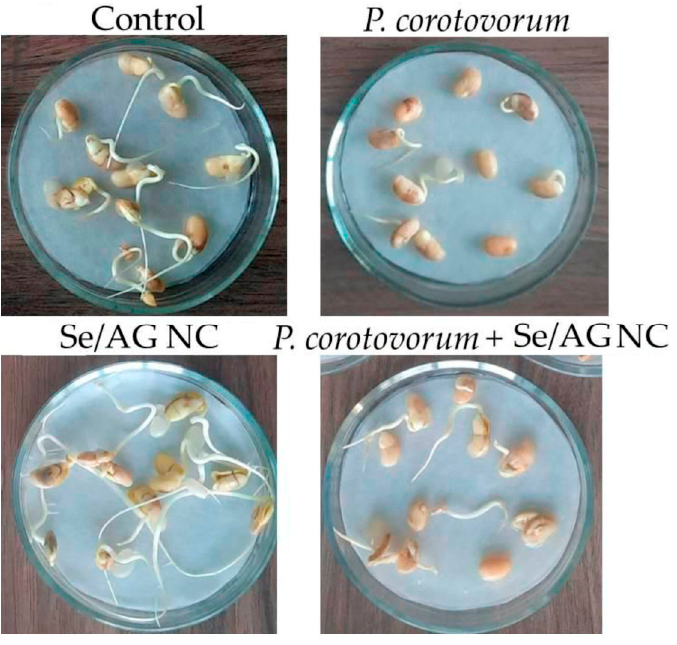
Figure 7. Effect of biopriming with Pectobacterium carotovorum and nanopriming with Se/AG NC on soybean germination after 7 days of germination. Table 2. Influence of Se/Ag NC on the length and weight hypocotyl and roots in soybean seedlings.